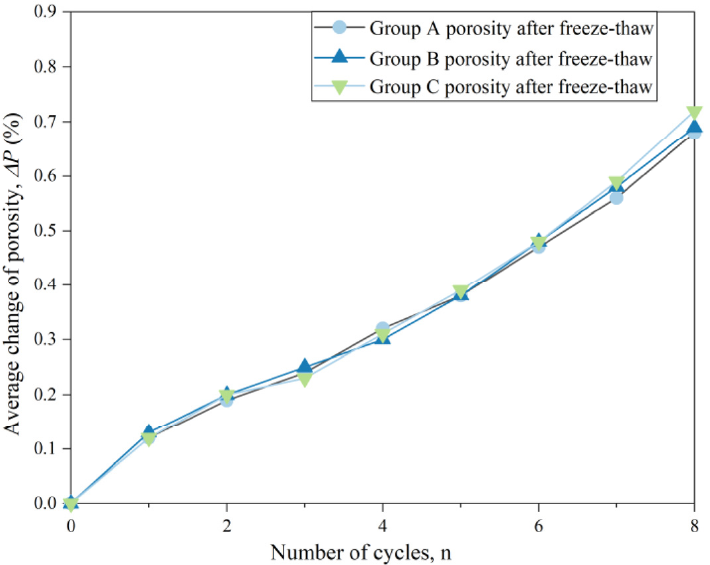
Figure 9. The relationship between the number of freeze-thaw cycles and the average change in porosity.